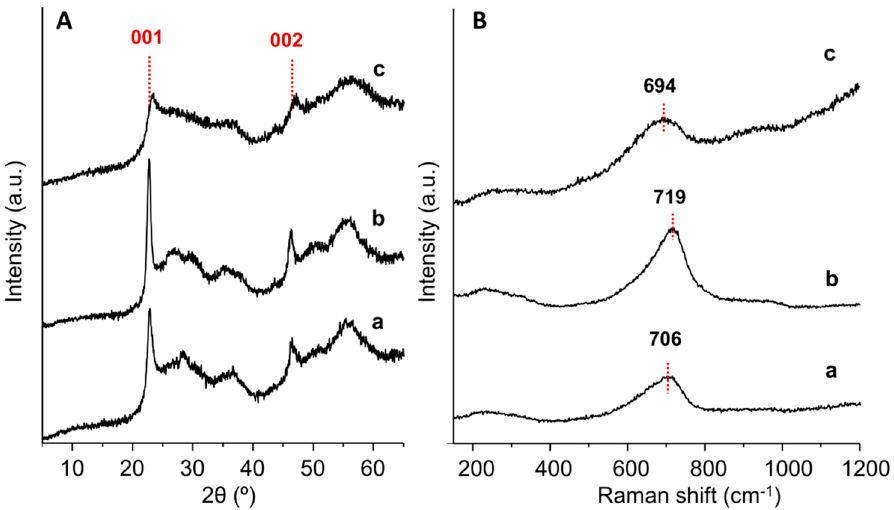
Figure 4. X-ray diffraction (XRD) patterns ( A ) and Raman Spectra ( B ) of Nb 2 O 5 -based supports: (a) Nb 2 O 5 ; (b) W-Nb 2 O 5 ; (c) Ti-Nb 2 O 5 .